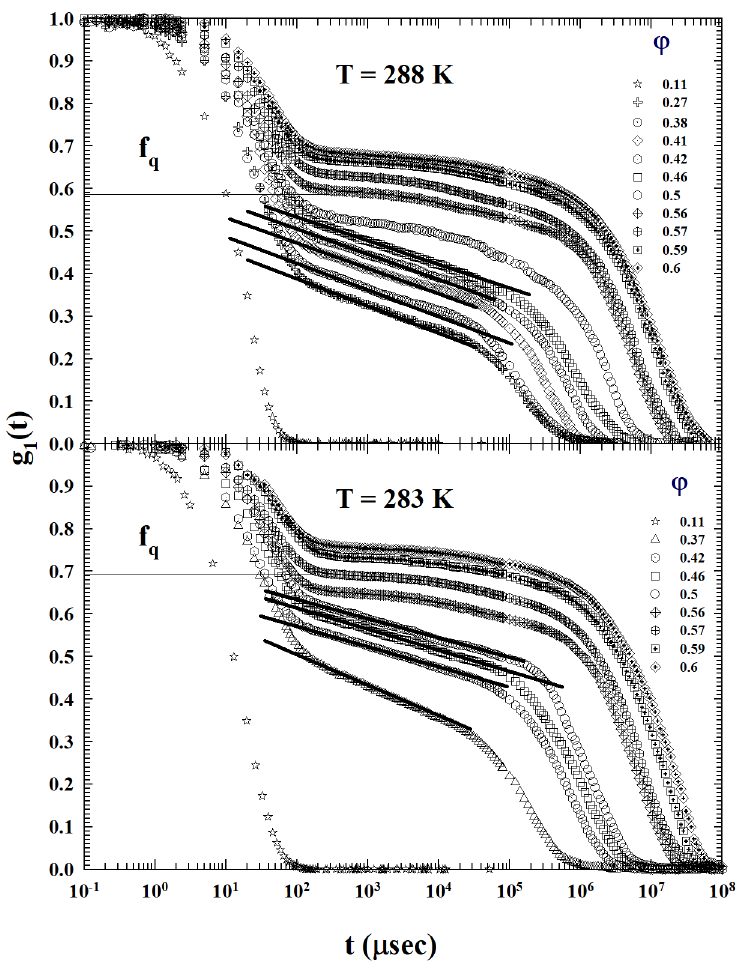
Figure 3. The ϕ behaviors of the dendrimer–methanol ISFs at the two lowest studied temperatures ( T = 288 and 283 K). As can be clearly seen at 283 K, the logarithmic decay is present in all the liquid states up to ϕ c , indicating that the system behaves fully as an